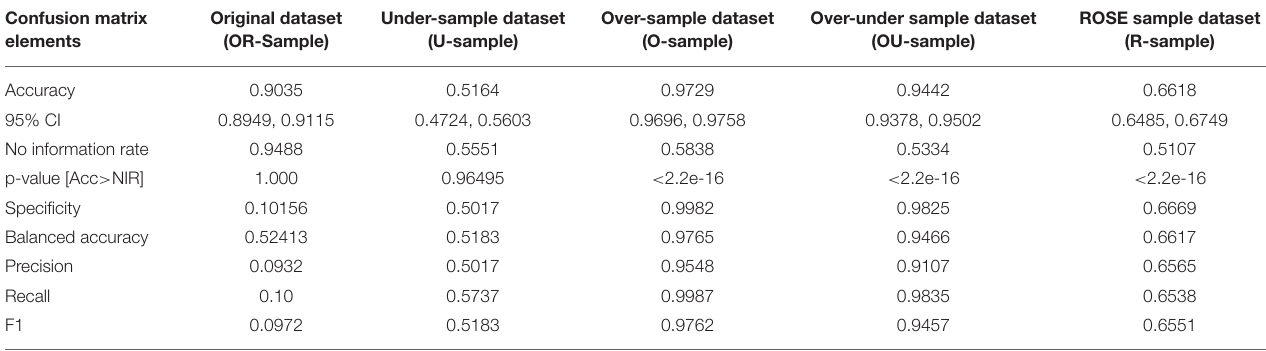
TABLE 3 | Measures of confusion matrix. Confusion matrix